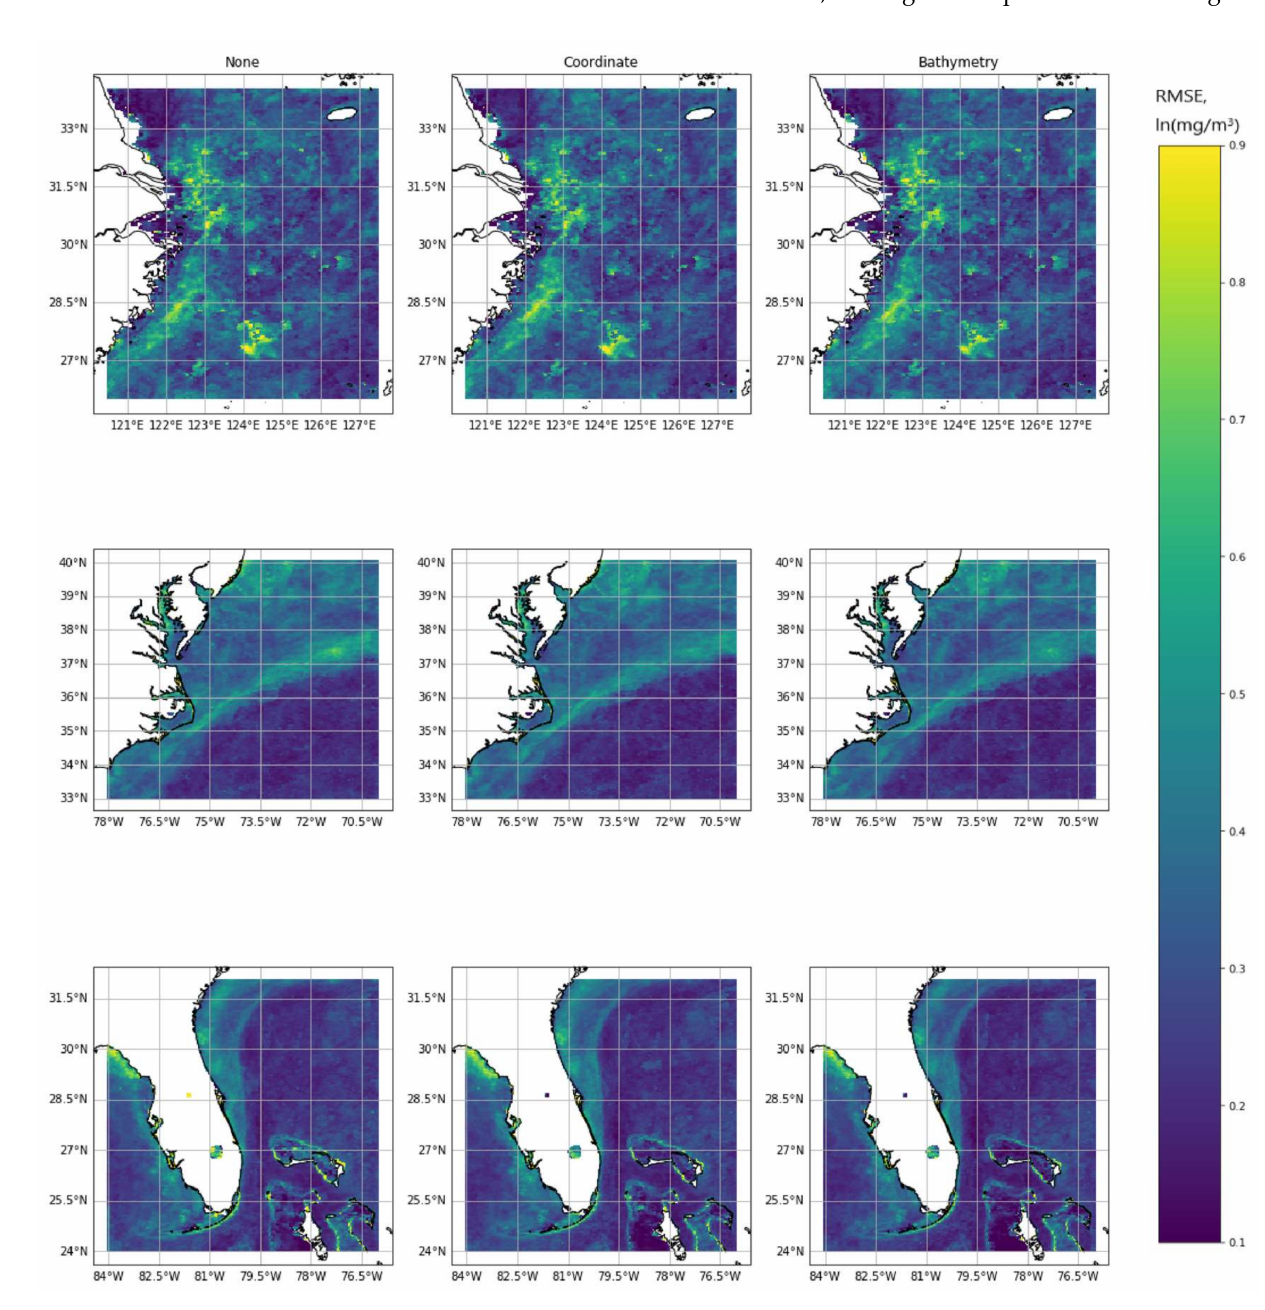
Figure 8. Spatial distribution of RMSE between ln ( Chl-a rec ) and ln ( Chl-a obs ) of models with 3 in- put